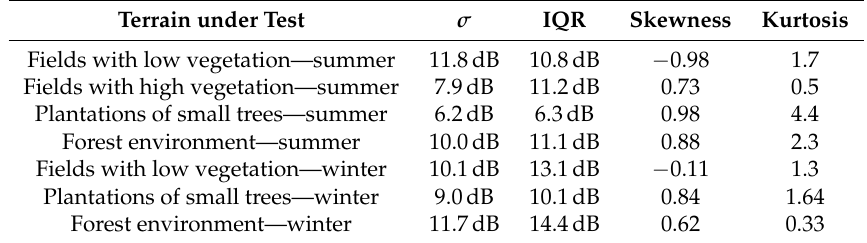
Table 2. Statistical properties of the clutter amplitudes for the different terrain types during summer and winter. Terrain under Test σ IQR Skewness Kurtosis Fields with low vegetation—summer 11.8dB Fields with high